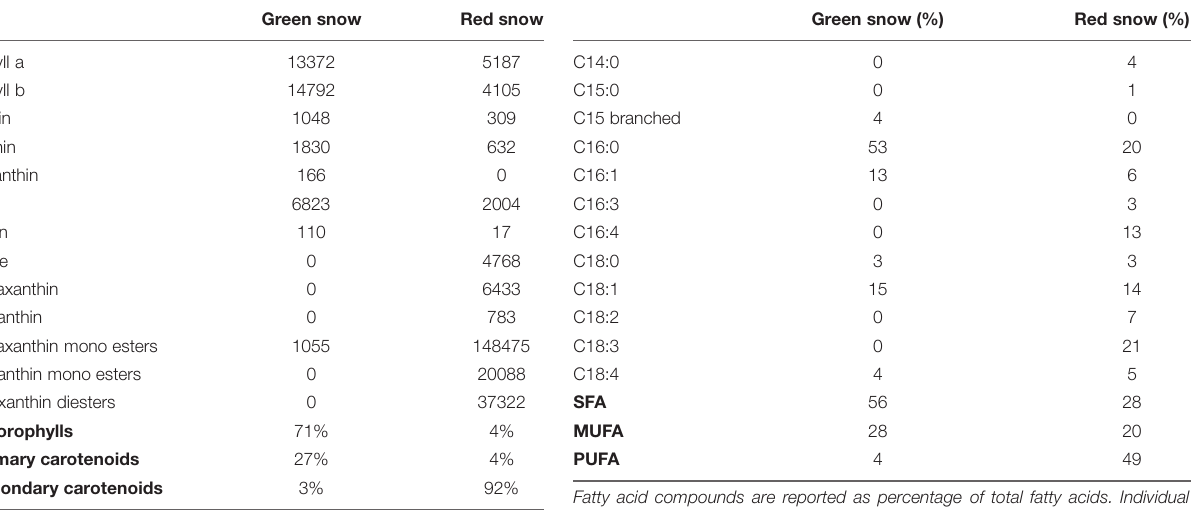
TABLE 5 | Pigment composition of green and red snow. TABLE 6 | Fatty acid composition of green and red snow. Green snow Red snow Green snow (%) Red snow